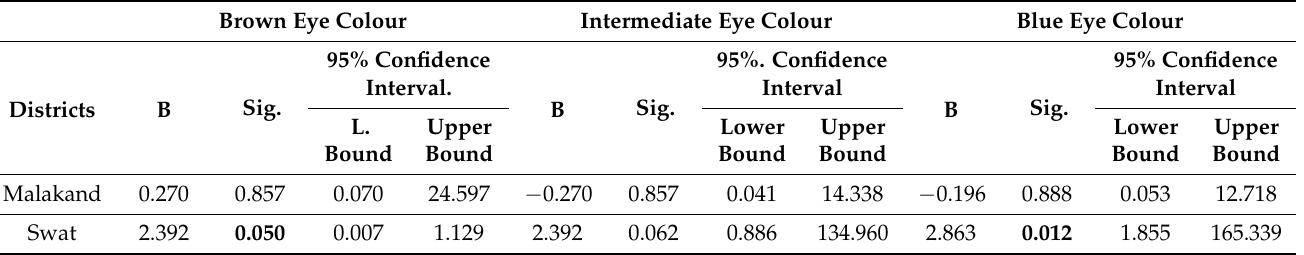
Table 5. Result of Multinomial logistic regression analysis between Districts and eye colour. The bold value indicated significant variable with eye